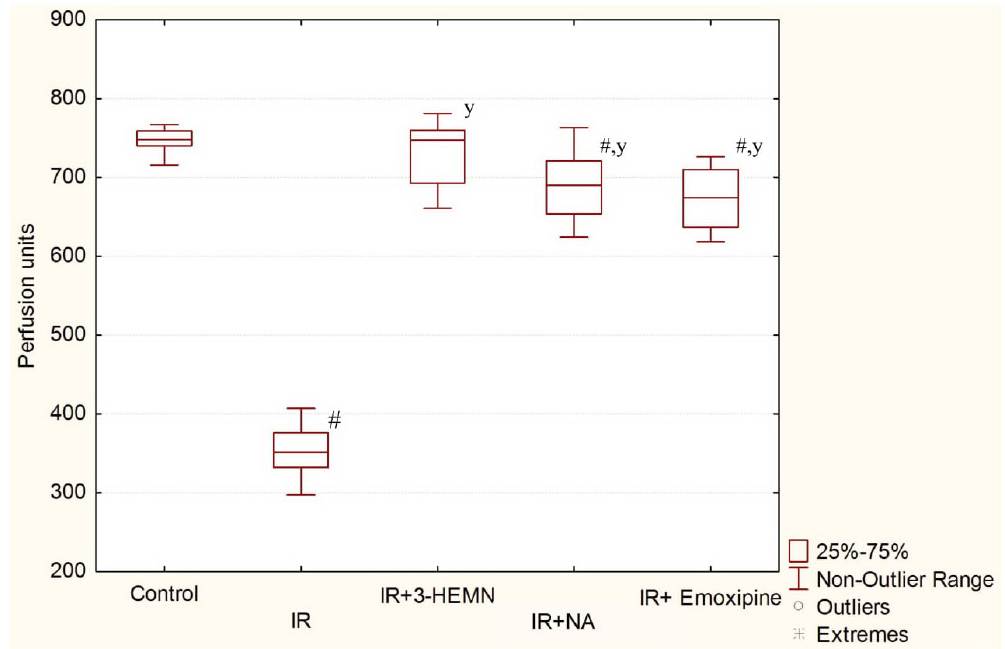
Figure 3. Retinal microcirculation level in experimental groups ( n = 10). IR: group with retinal ischemia–reperfusion; IR + 3-HEMN: group with retinal ischemia–reperfusion treated with 2-ethyl-3-hydroxy-6-methylpyridine nicotinate; IR + NA: group with retinal ischemia–reperfusion treated with nicotinic acid; # p = 0.0002 compared to the control (for IR group); y p = 0.0002 compared to the ischemia–reperfusion model (for the IR + 3HEMN group); # p = 0.0065 compared to the control (for the IR + NA group); y p = 0.0002 compared to the ischemia–reperfusion model (for the IR + NA group); # p = 0.0002 compared to the control (for the IR + Emoxipine group); y p = 0.0002 compared to the ischemia–reperfusion model (for the IR + Emoxipine group).